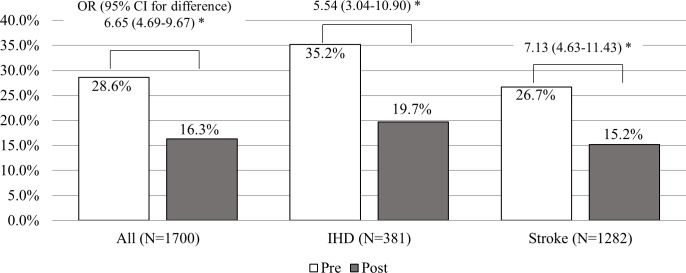
Comparison of current smoking rate between pre-diagnosis and post-diagnosis.* All differences were statistically significant by McNemar’s test (p < 0.001).